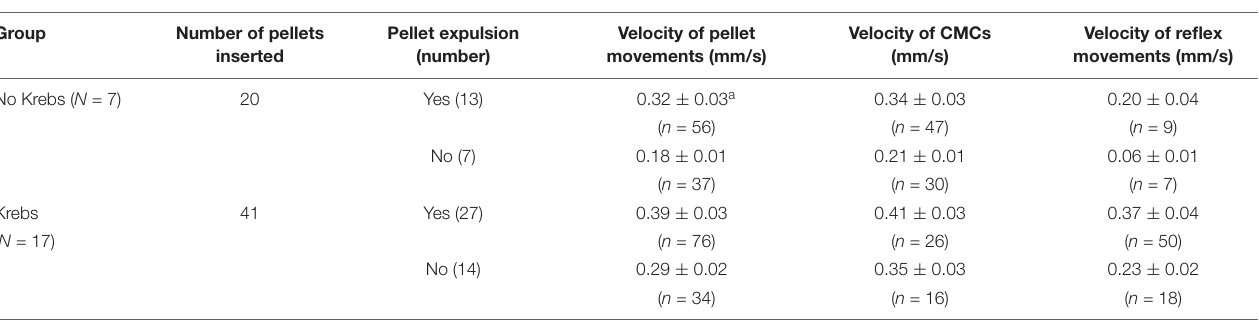
TABLE 2 | Velocities of motor patterns with and without Krebs perfusion.